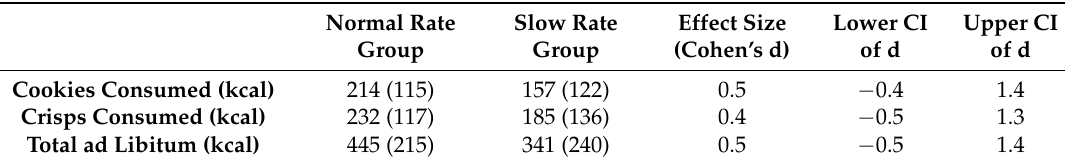
Table 3. Ad libitum energy intake (mean; SD).